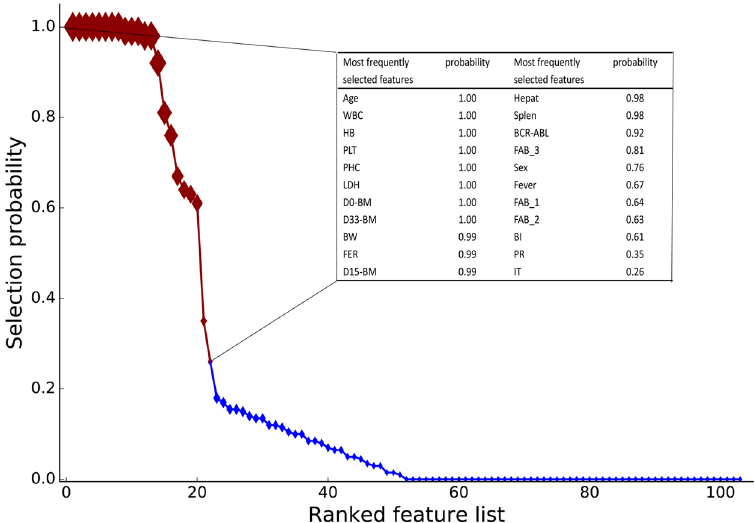
tree-based algorithms, Random Forest (RF) and Decision Tree (DT), were clearly superior to Logistic Regression (LR) and Support Vector Machine (SVM), because of unbalanced low sensitivities versus high specificities of the latter methods. Furthermore, RF exhibited better prediction than DT in 4 of 6 measurements (accuracy: 0.831 vs. 0.791; specificity: 0.895 vs. 0.773; PPV: 0.880 vs. 0.781; AUC: 0.902 vs. 0.792). Therefore, of the four algorithms analyzed, the RF model seems to be most suitable for the relapse classification problem.